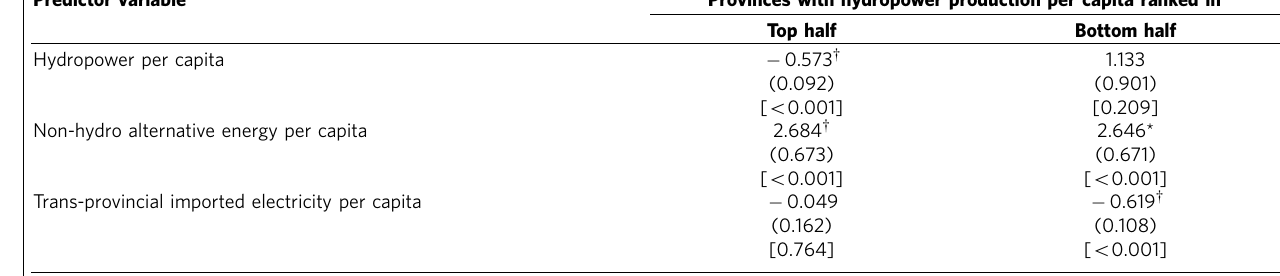
Shown are displacement coefficients estimated from panel analyses of data from 30 provinces and municipalities during 1995–2014, where the electricity demand is modelled as controlled by GDP per capita.Thedisplacementcoefficientsoftrans-provincialimportedelectricityaresummarizedalongwiththoseofhydropowerandnon-hydroalternativeenergysources,whilefullresultsforthemodelare presented in Supplementary Table 10. *Overall ranking of the 30 provinces and municipalities in hydropower production per capita during 1995–2014 is listed in Supplementary Table 9. w Statistically significant at the 0.05 alpha level (two-tailed test), s.e.’s are reported in parentheses, while P values are presented in